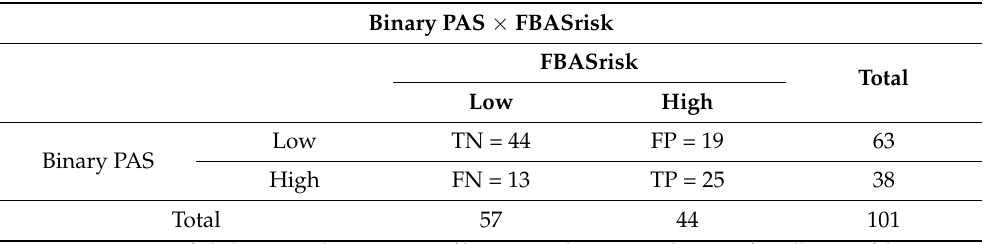
Table 3. Total number of false positives, false negatives, true negatives, and true positives for the Functional Bedside Aspiration Screen (FBAS; 2 × 2 contingency table). Binary PAS × FBASrisk FBASrisk Total Low High Low TN = 44 FP = 19 63 Binary PAS High FN = 13 38 57 44 101